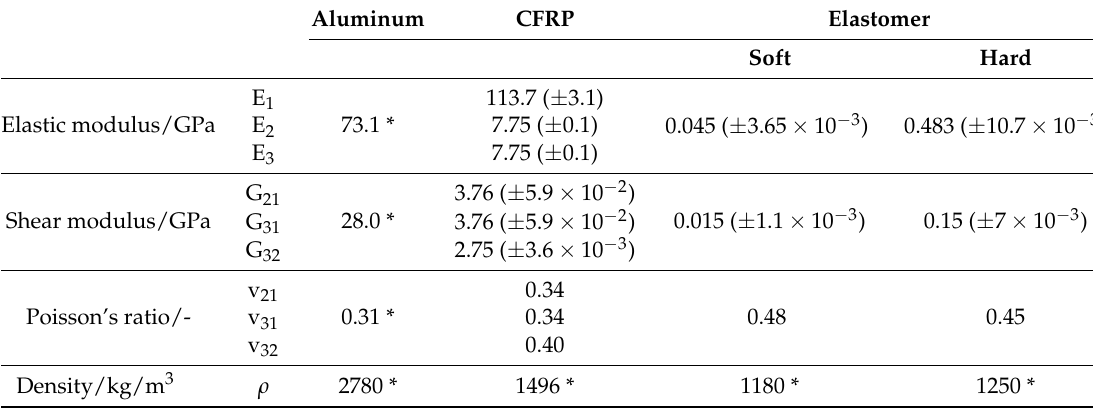
Table 1. Quasistatic material data for aluminum, CFRP and elastomer material. Values with * are values from the corresponding data sheets, which can be obtained from the suppliers on